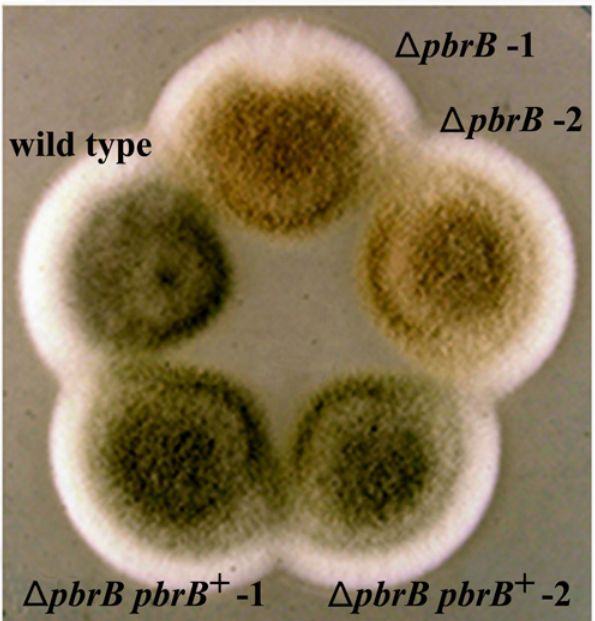
Fig 5. Macroscopic morphologies of the wild type and mutant T . marneffei strains. Colonies of the wild type T . marneffei control strain G681, Δ pbrB 1&2 strains, and Δ pbrB pbrB + 1&2 complemented strains grow on ANM agar at 28°C for 14 days. Conidiation of the Δ pbrB strains is brown compared to the green conidiation of the parental and complemented strains.